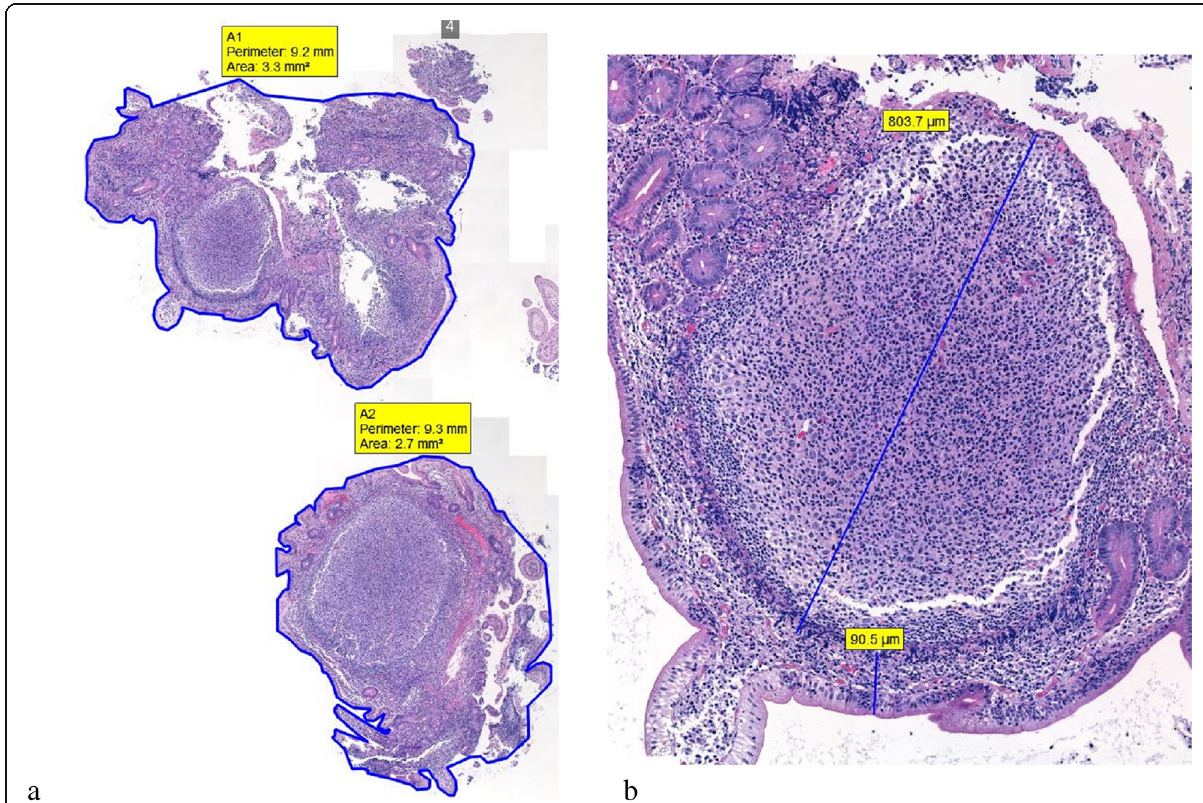
Fig. 1 A representative example (Case no. 3) of using whole slide imaging in measuring various parameters. a , The density (D) of follicles is measured by dividing the number of lymphoid follicles by the total surface area of the biopsy specimen (with summation of the measurements from all the tissue fragments; D = number of follicles/area; in this case, 2/(3.3 + 2.7) = 0.3333). b , This panel shows the diameter (the greatest dimension) of a follicle (803.7 μ m) and the nearest distance of this follicle to the surface epithelia (90.5 μ